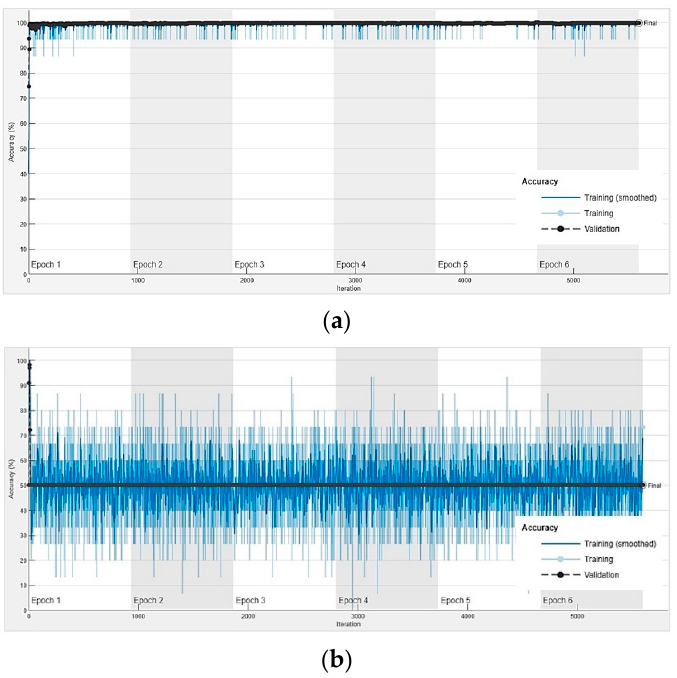
Figure 3. Training progress plot of accuracy (%) with different learning rates: ( a ) 0.0001; ( b ) 0.001.